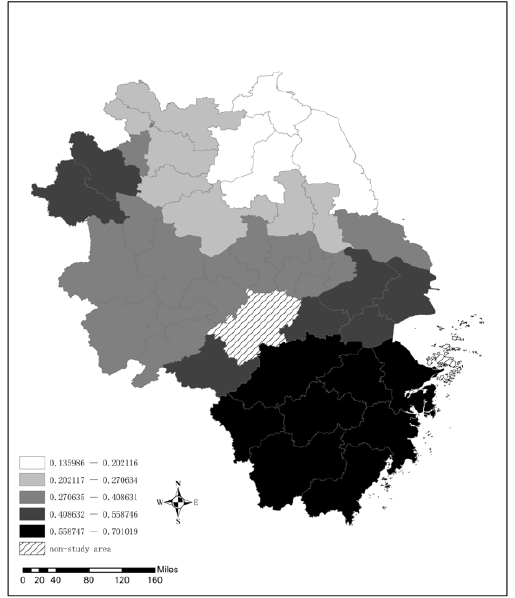
Figure 7. The spatial distribution of the regression coefficient for Tran .